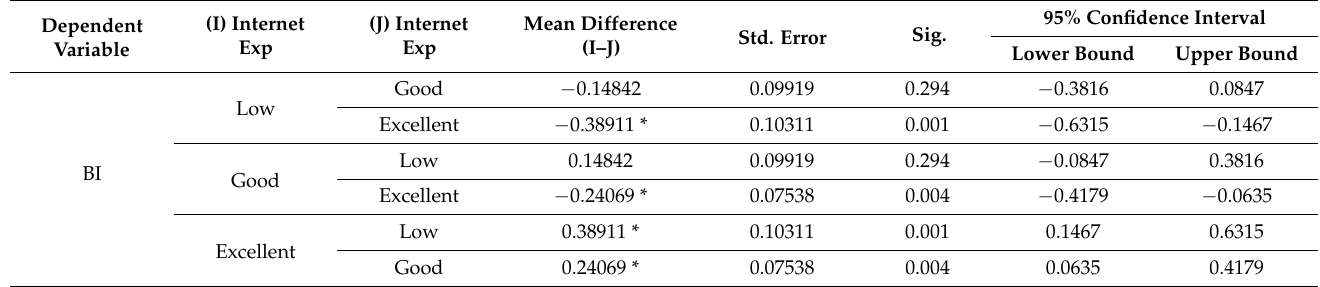
Table 16. Multiple comparisons analysis of the BI attributed to internet experience using Tukey HSD.